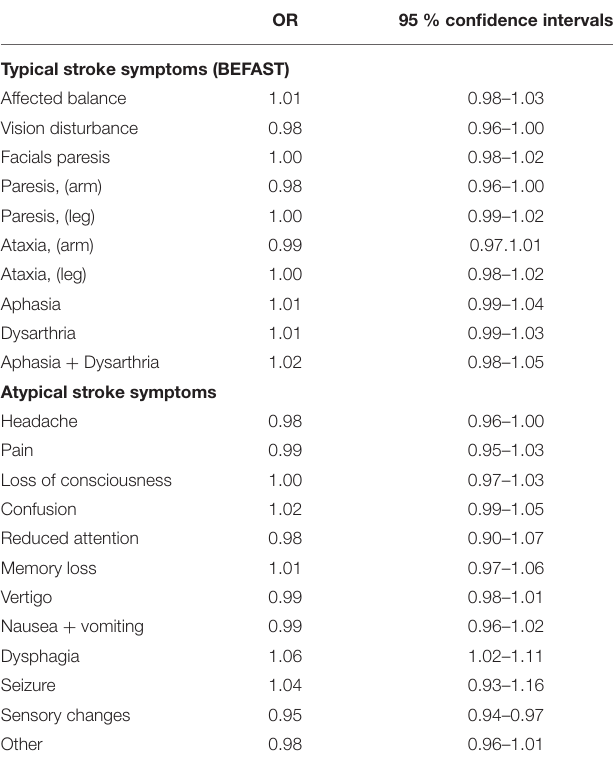
TABLE 4 | Age-related differences in patient-reported stroke symptoms with each year increase. OR 95 % confidence